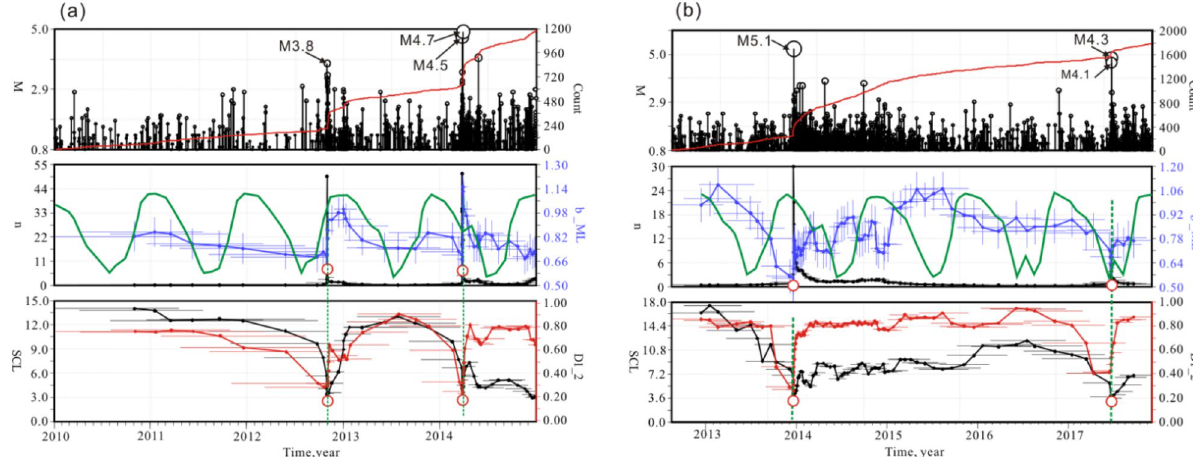
Figure 9. Temporal variations in earthquake accumulated number, magnitude, b -value, SCL, and D in the Zigui area ( a ) and Badong area ( b ). Green solid lines show the water level variations with time. Black empty circles show the moderate earthquakes occurred in the Zigui and Badong